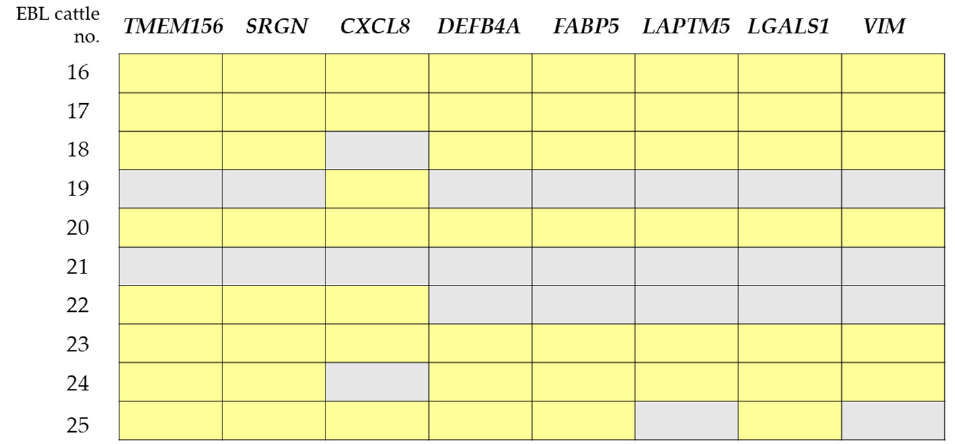
Figure 5. Quantities of mRNA biomarker candidates in each of the 10 EBL cattle. The yellow and gray blocks indicate whether the quantity of mRNA is higher or lower in sEVs from EBL cattle in comparison to the mean quantity of the uninfected cattle.